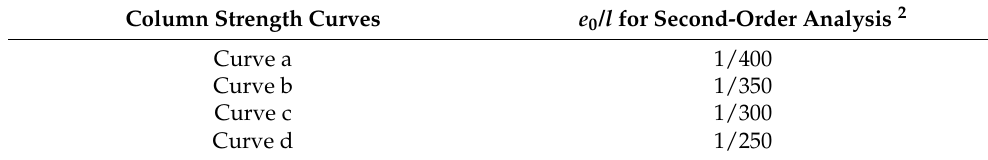
Table 2. Representative values of comprehensive imperfections of members Table 5.2.2 in GB50017 [16]). Column Strength Curves e 0 / l for Second-Order Analysis 2 Curve a 1/400 Curve b 1/350 Curve c 1/300 Curve d 1/250